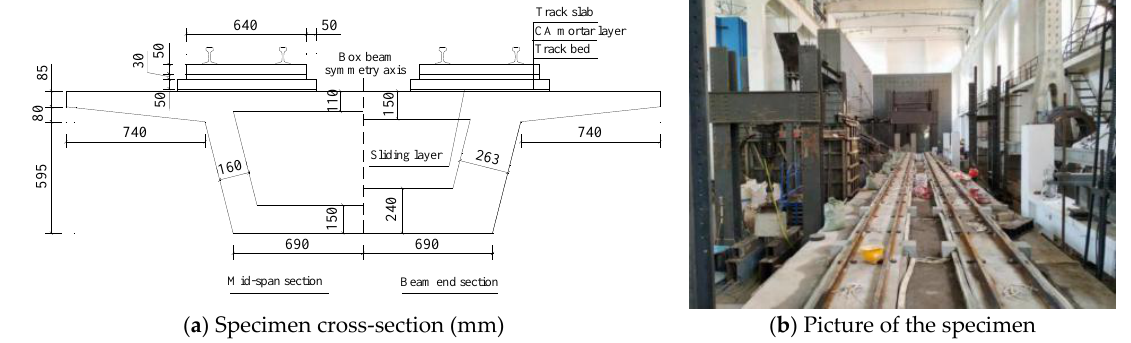
Figure 1. Specimen structure.